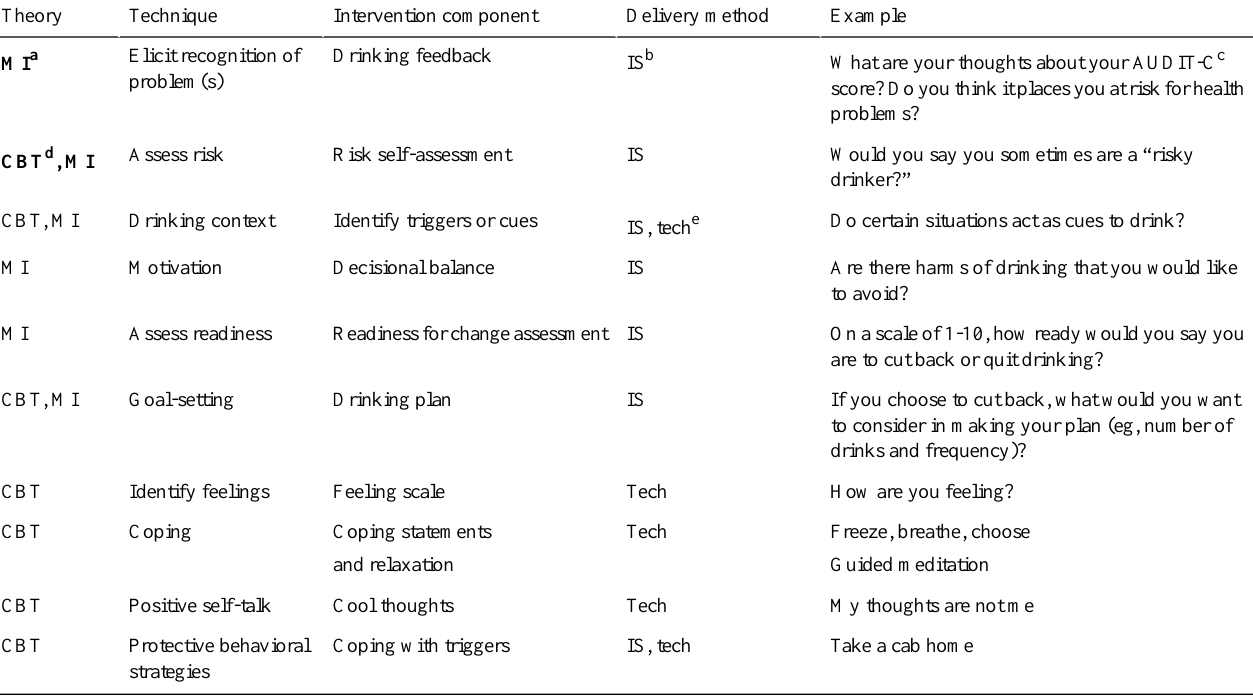
Table 1. Theory table.